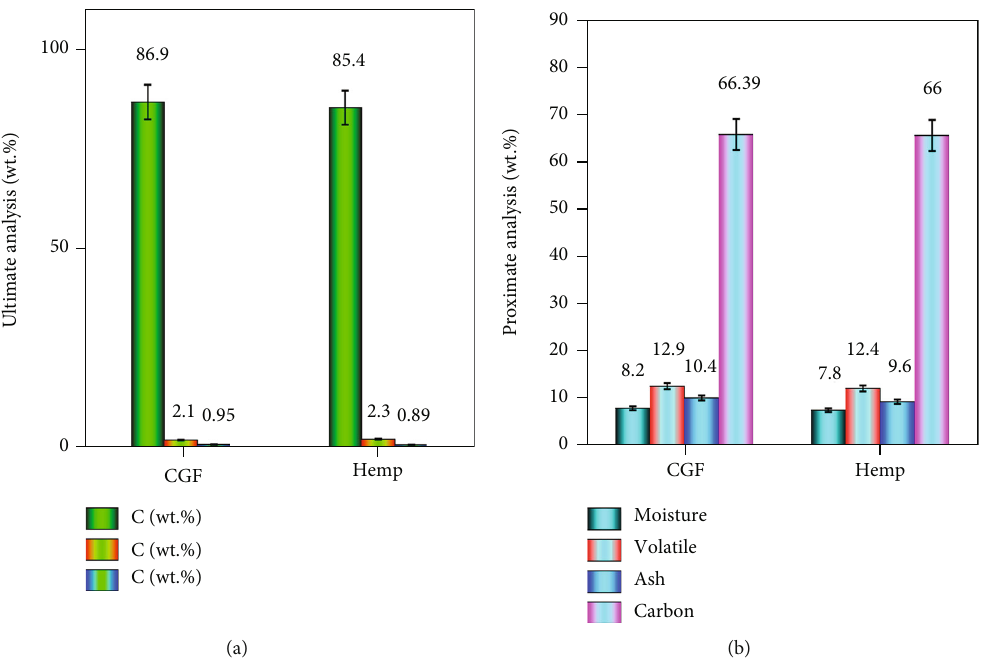
Figure 11: (a) Ultimate analysis; (b) proximate analysis of CGF and hemp-based natural fi